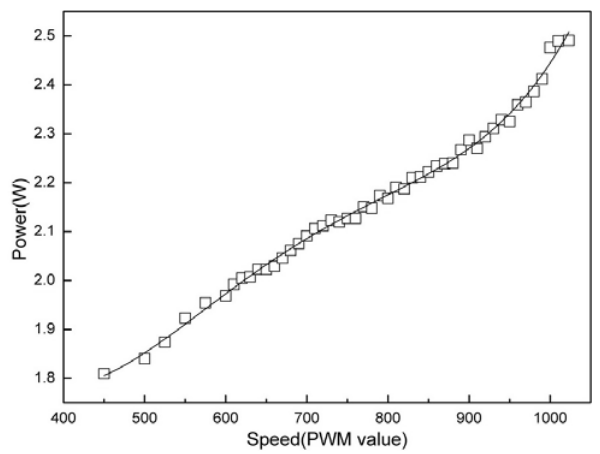
Figure 14. Power model of the mobile